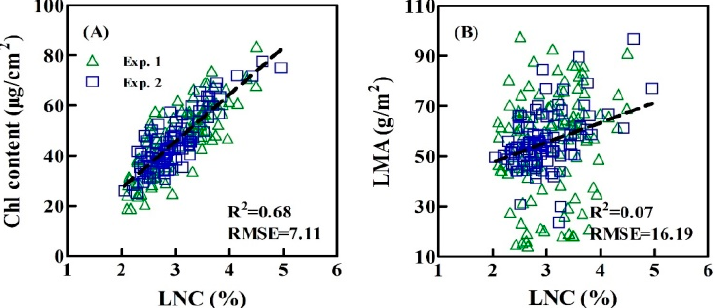
Figure 10. Chl content ( A ) and LMA ( B ) versus LNC for two ecological datasets. The data of Experiment1 and Experiment 2 are shown in green (triangle) and blue (square), respectively.